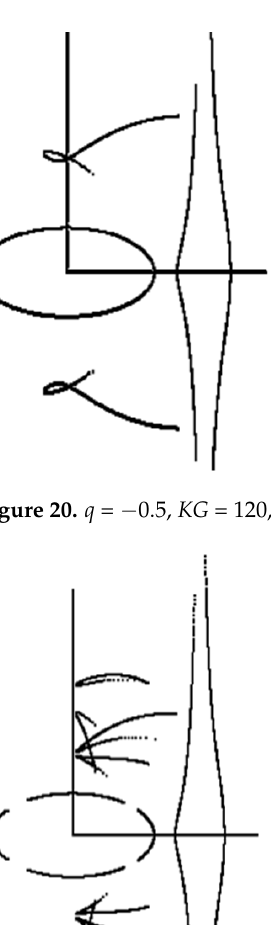
Figure 19. q = - 1, KG = 100, and DK = 100.